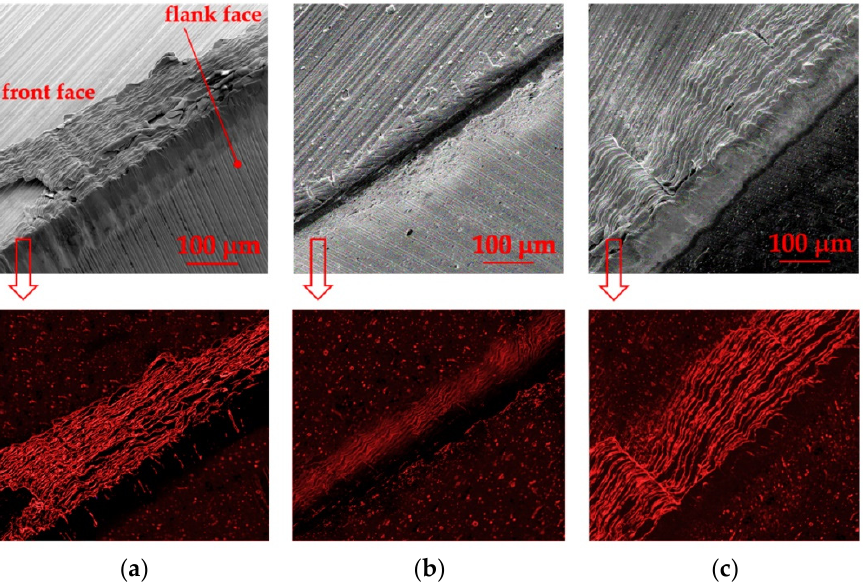
Figure 11. The condition of the working surfaces of ball end mills with different coatings and contrast SEM images of the distribution of nickel (particles in red) on the working surfaces of end mills when machining a nickel alloy at a cutting speed of 250 m/min: ( a ) uncoated; ( b ) with TiN–AlN–TiAlN coating; ( c ) with CrAlSiN–DLC coating.